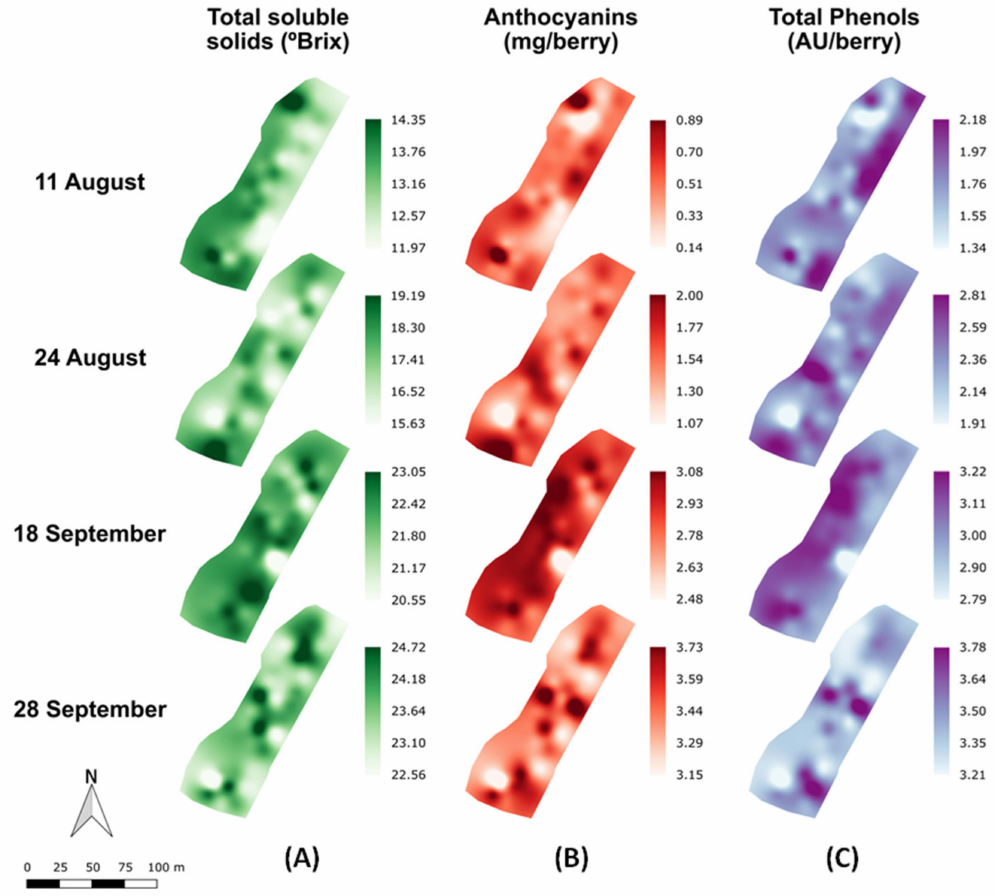
Figure 3. Prediction maps of the spatial variability of anthocyanins ( A ), total soluble solids ( B ), and total polyphenols concentrations ( C ) along the grape ripening period (11 August to 28